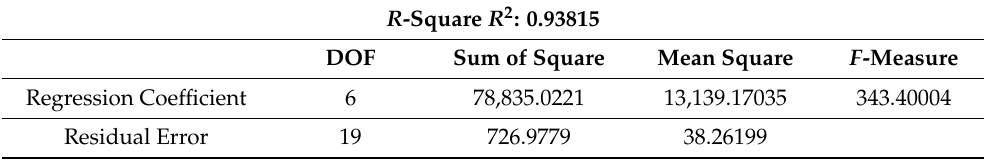
Table 5. Significance analysis of model 1.